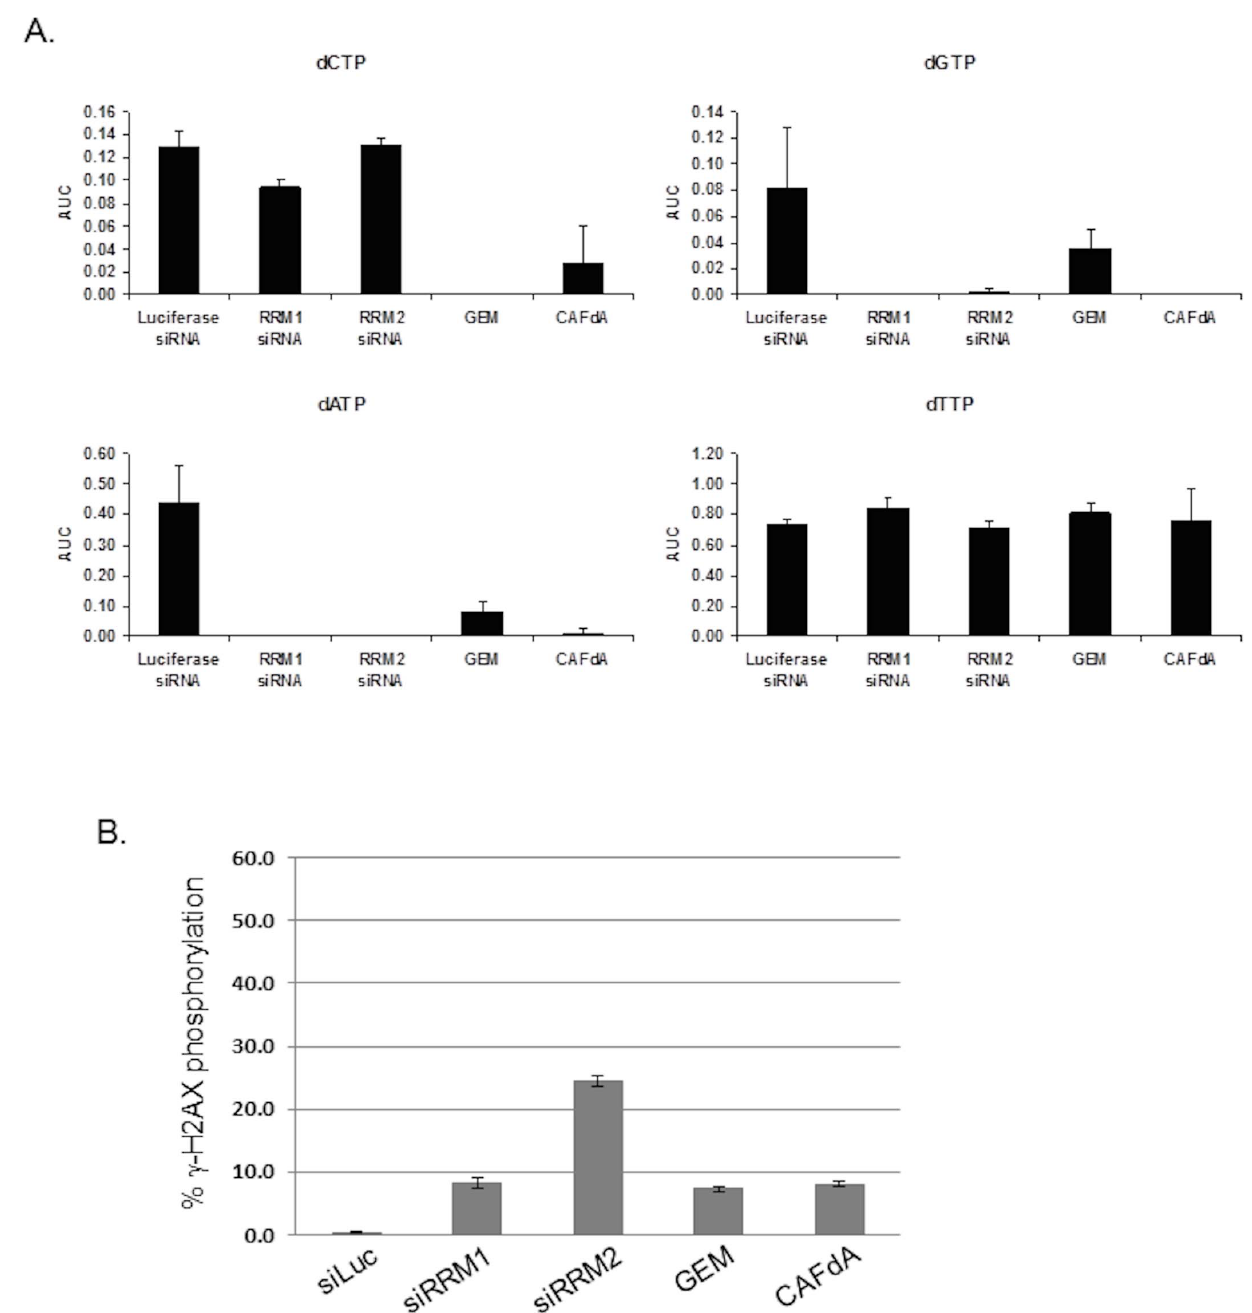
Figure 1. Quantitation of dNTPs and c -H2AX phosphorylation in U20S cells following depletion of RRM1 and RRM2 subunits of Ribonucleotide reductase. Cells were transfected with RRM1, RRM2 and Luciferase control (untreated or treated with 1 m M GEM or 1 m M CAFdA for the last 2 h) before harvesting at 30 h. At 30 h after siRNA transfections, (a) NTP/dNTP extractions were prepared and quantified. (b) DNA damage was assessed for c -H2AX phosphorylation using flow cytometry. Data performed in triplicates. Error bars represent standard deviations (SD) between experiments.